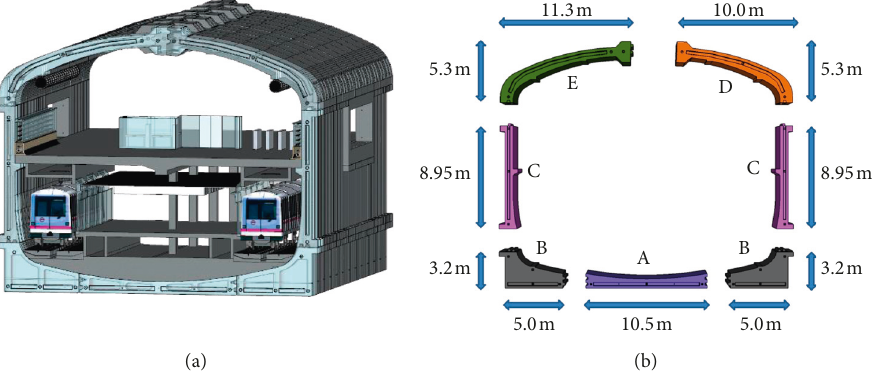
Figure 1: Prefabricated metro station.